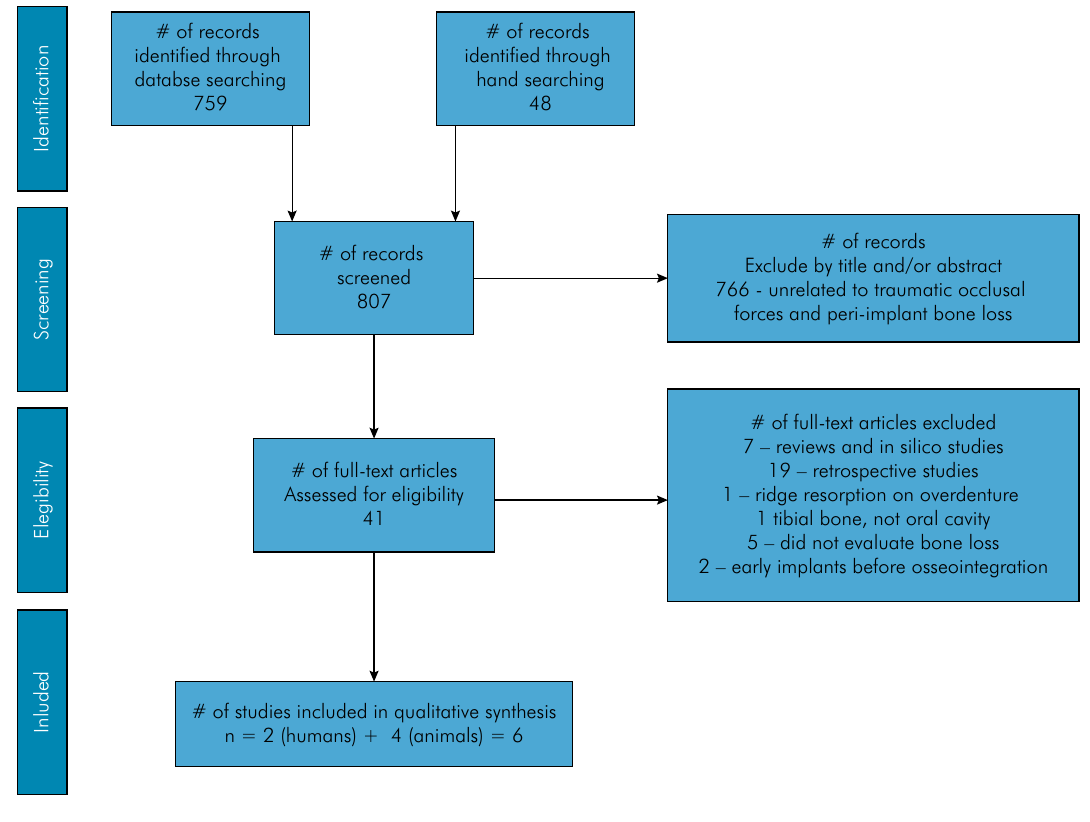
Figure. Flow chart of screened, withdrawn and included articles through the review process.